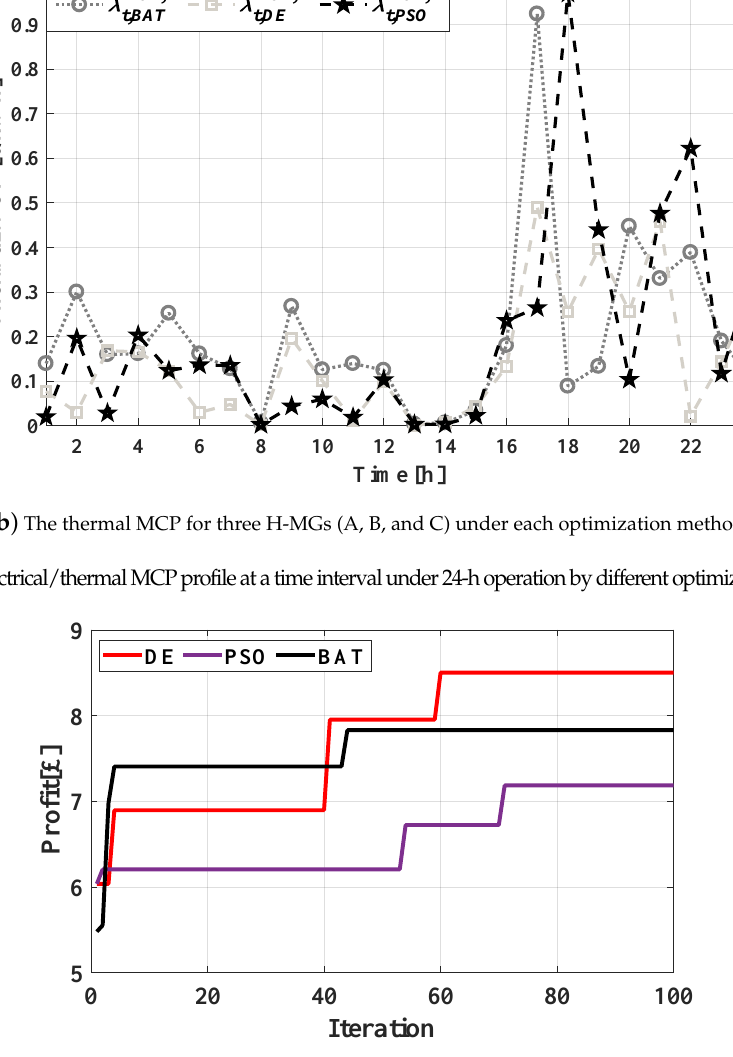
Figure 12. Convergence characteristics of the proposed